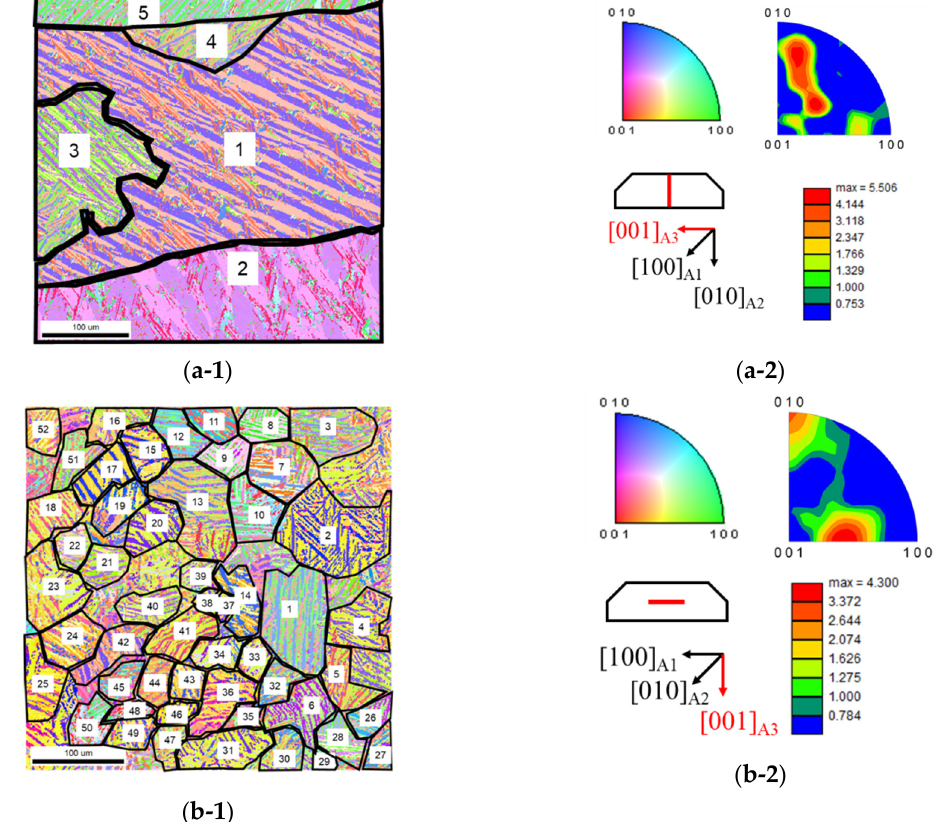
Figure 2. Inverse pole figures and texture plots on A3 direction of equiatomic TiPd alloy. ( a ‐ 1,2 ) 90 and ( b ‐ 1,2 ) 0 degrees sample.